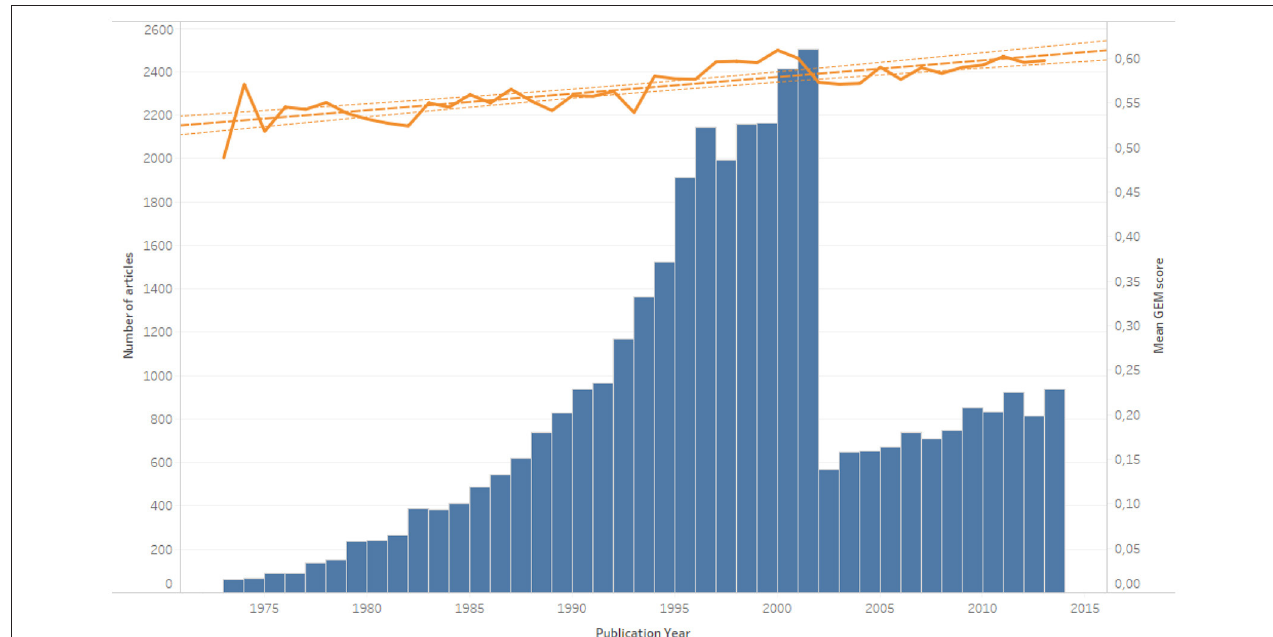
FIGURE 6 | Temporal distribution of the number of articles and mean GEM score (1975–2013).